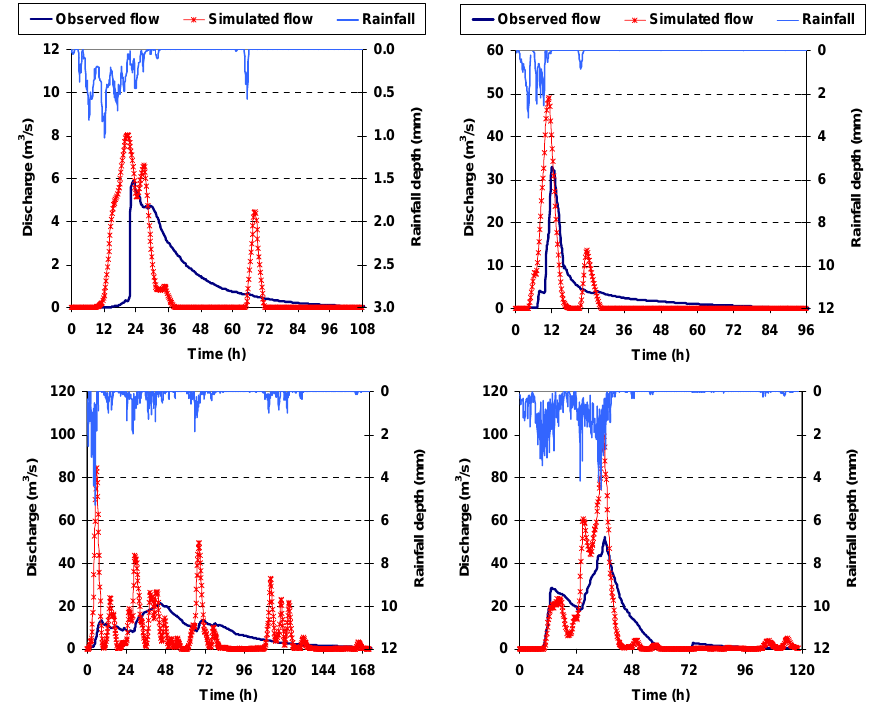
Figure 1. Observed and simulated (through the SCS/SUH method) hydrographs and corresponding rainfall events in Sarantapotamos (upper panel; February 2012, left, and February 2013, right) and Peristerona (lower panel; March 1988, left, and January 2004, right).